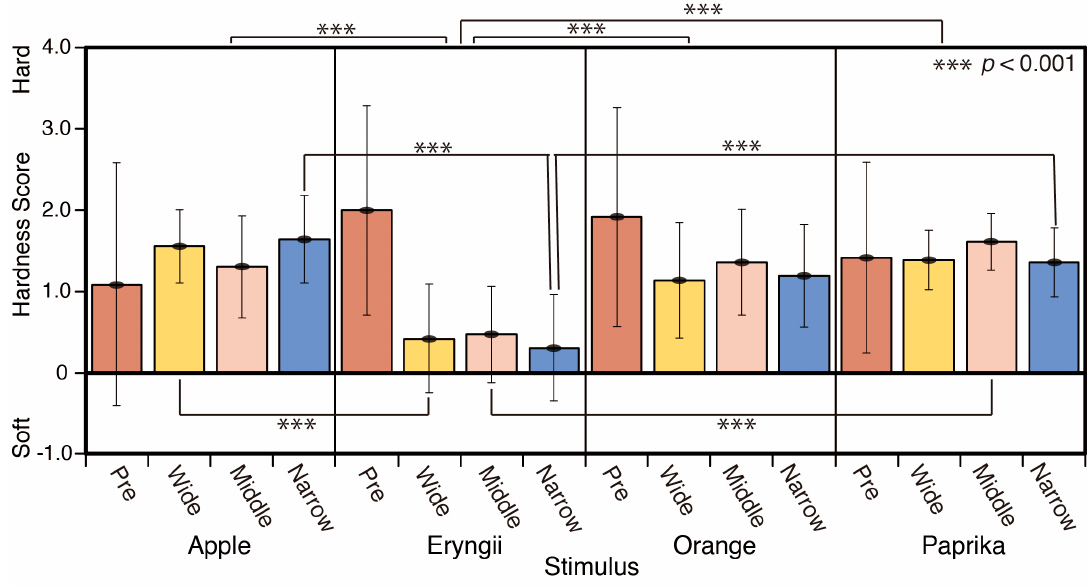
Figure 19. Hardness scores.